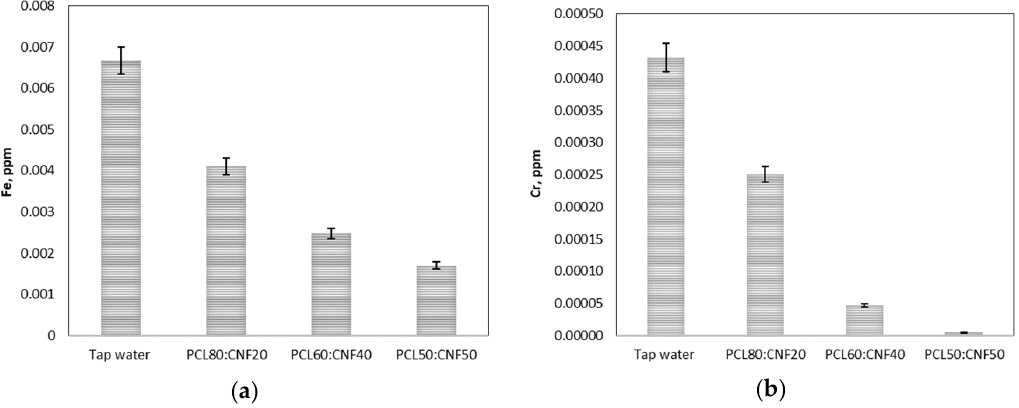
Figure 6. Removal of heavy metals in tap water using PCL/CNF ( v / v ) ratio (80:20, 60:40, and 50:50) composite electro-spun membranes: ( a ) Iron (Fe) and ( b ) Chromium